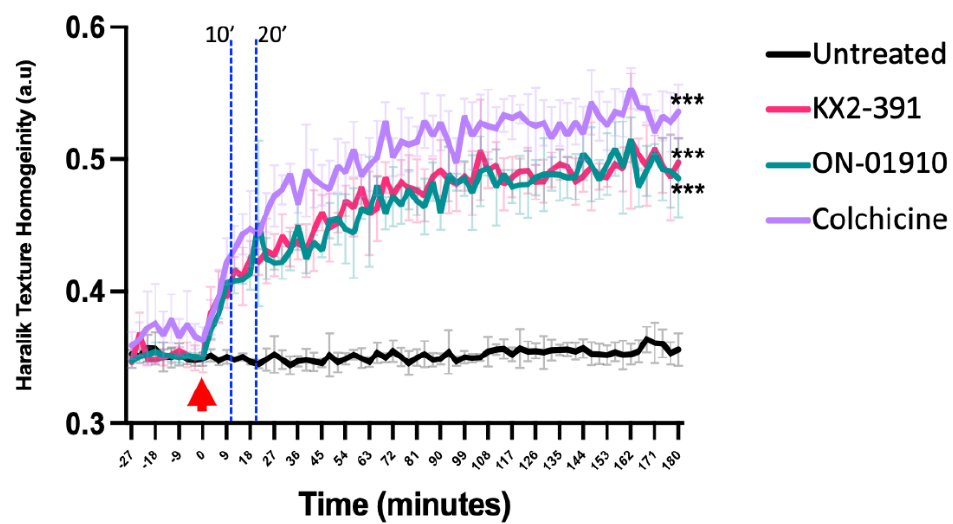
Figure 4. Live cell tracking of the inhibition of tubulin polymerization by detecting changes in the Haralick homogeneity values. HeLa cells with endogenous tagging of β -tubulin and histone H1 were treated with ON-01910, KX2-391, and colchicine as a positive control to detect the tubulin polymerization inhibition over a period of three hours. Imaging capture (every three minutes) started 30 min before adding the compounds and continued for a total of three hours. The red arrow indicates the start of the compound treatment. The two vertical dashed lines indicate the 10 and 20 min timepoints. Differences between drug treatments vs. untreated control were analyzed by two-way ANOVA, and p < 0.05 was considered statistically significant. *** p < 0.001; error bars represent ± SD of triplicate wells. This figure is representative of three independent experiments.